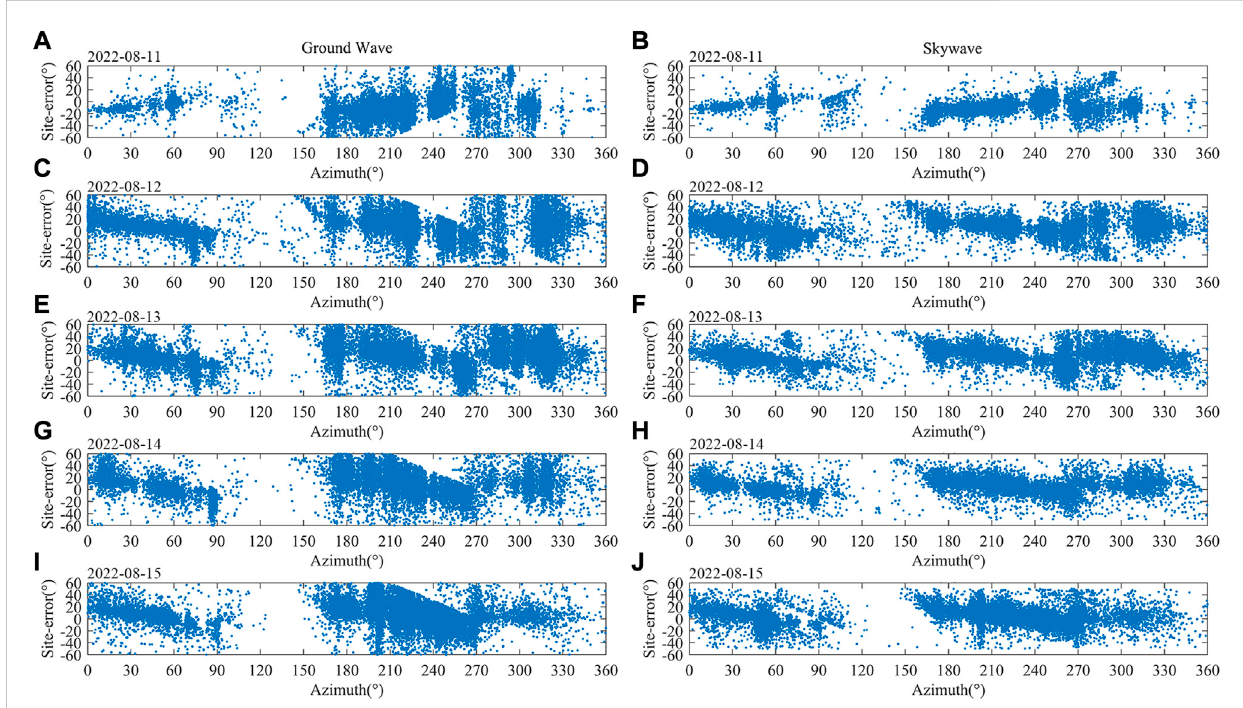
FIGURE 8 Scatter graph of site error distribution. (A) On August 11, based on the ground wave peak; (B) On August 11, based on the skywave peak; (C) On August 12, based on the ground wave peak; (D) On August 12, based on the skywave peak; (E) On August 13, based on the ground wave peak; (F) On August13,basedontheskywavepeak; (G) OnAugust14,basedonthegroundwavepeak; (H) OnAugust14,basedontheskywavepeak; (I) OnAugust15, based on the ground wave peak; (J) On August 15, based on the sky wave